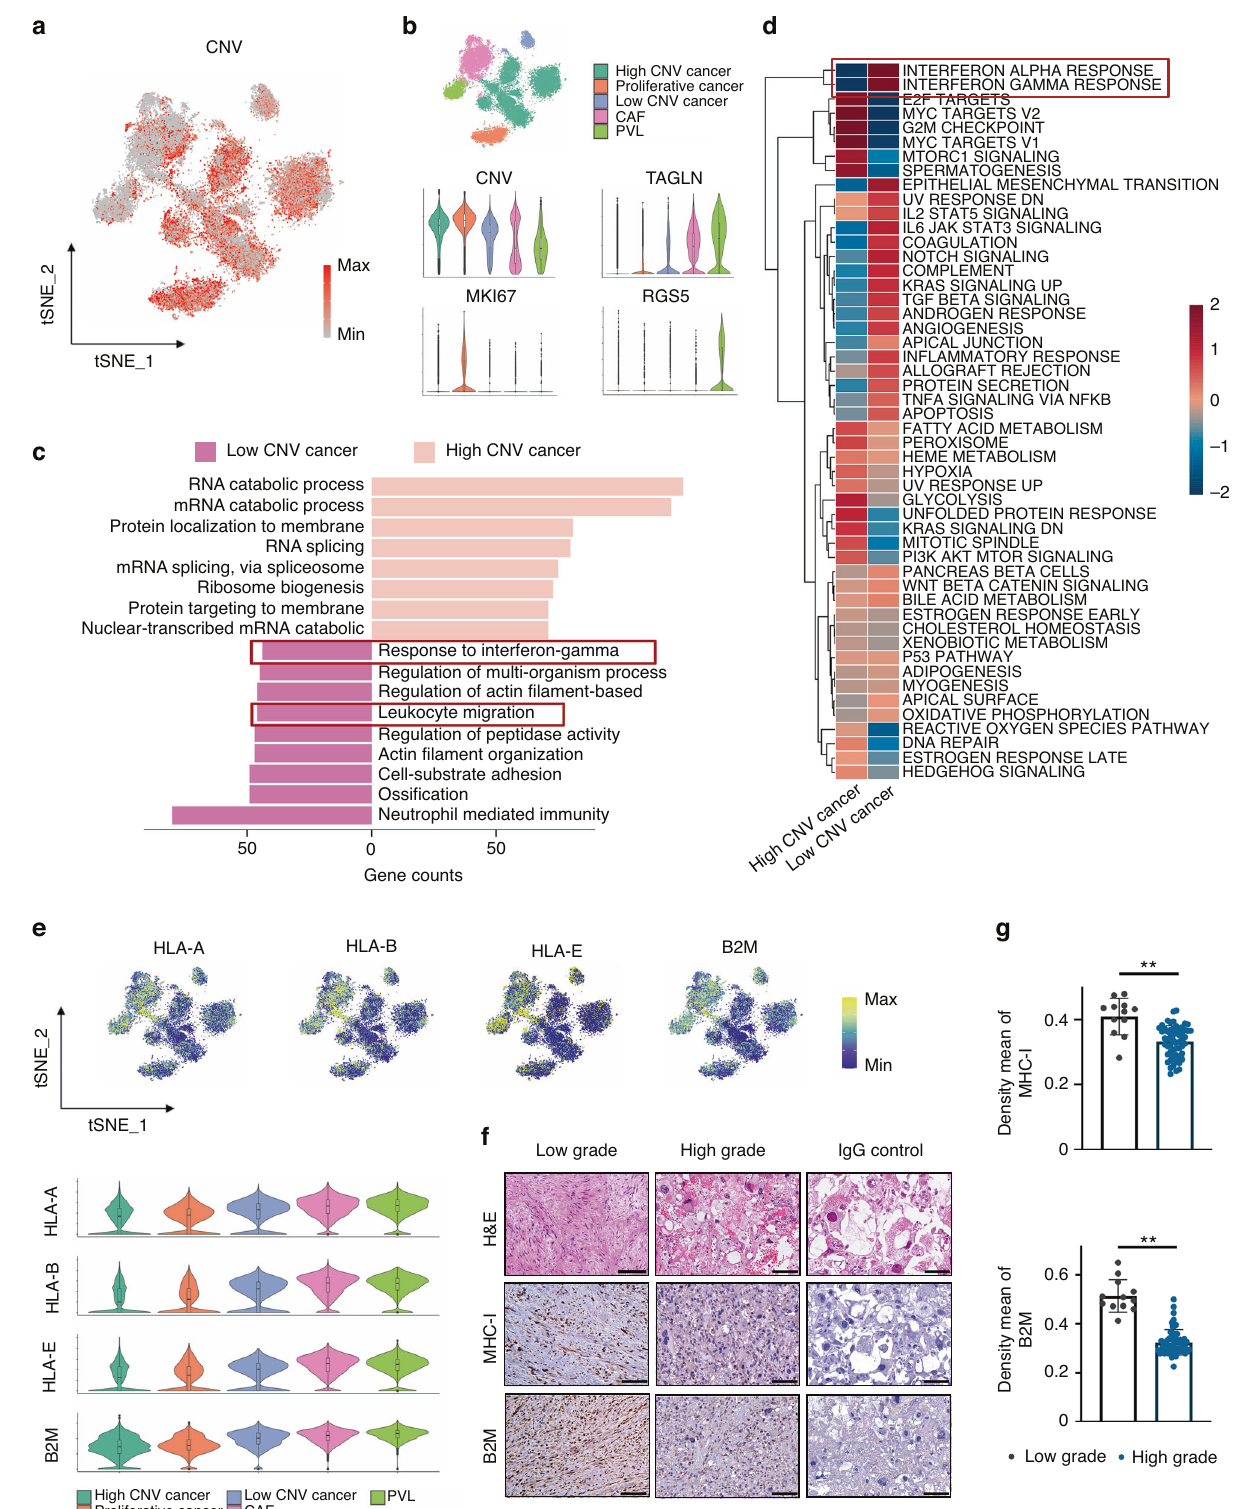
Fig. 4 The heterogeneity of cancer cell immunogenicity. a tSNE plot representing the single-cell copy number variations (CNVs) of cancer cells. Red represents high levels of CNV, and gray represents low levels of CNV. b tSNE plots of stromal cells colored by cluster (top); violin plots of CNV score and marker gene expression levels (bottom). c Bar plot showing the enriched Gene Ontology enrichment of differentially expressed genes between CNV high and low cancer cells. d Heatmap revealing the differentially regulated pathways between CNV high and low cancer cells scored by GSVA. Red represents high scores; blue represents low scores. e tSNE plots and violin plots showing the expression of HLA-A, HLA-B, HLA-E and B2M in stromal cells. f and g Representative immunohistochemistry and mean density of MHC-I and B2M expression in low-grade and high-grade OS tissue. Scale bar, 100 μ m. Data are the means ± SEMs. * P < 0.05; ** P <